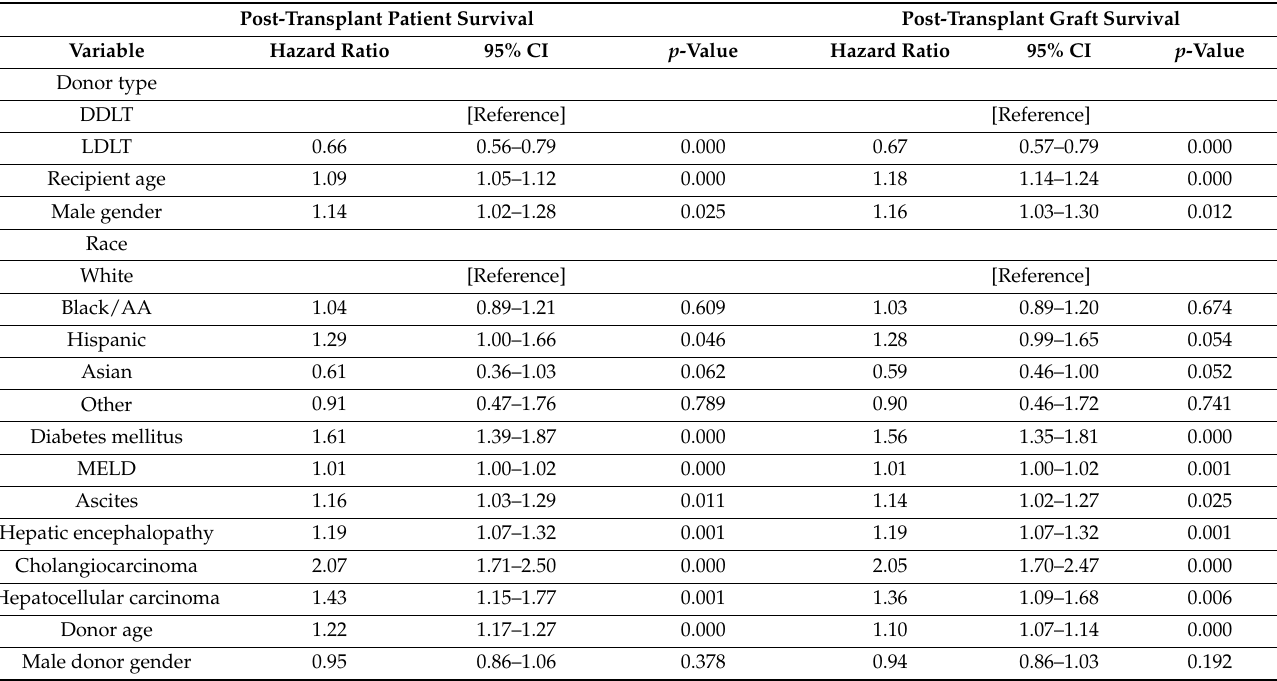
Table 2. Univariate Cox proportional hazard analyses of predictors of post-transplant patient survival and post-transplant graft